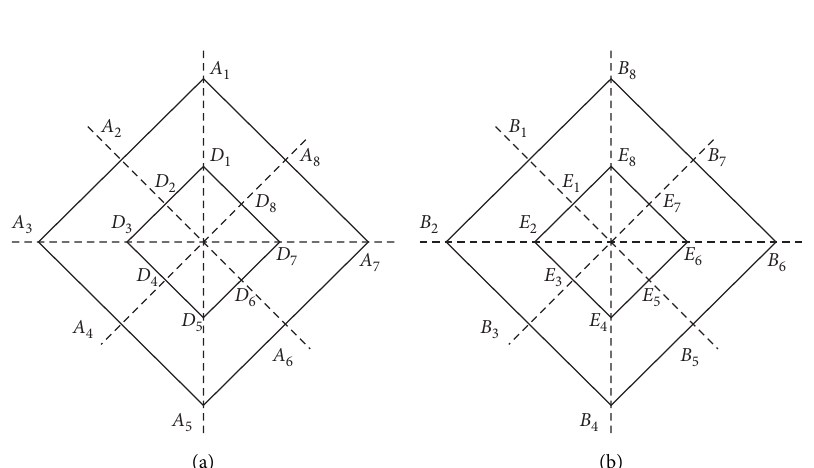
Figure 4: Finding vertex correspondence. (a) Graph 1 (source shape). (b) Graph 2 (target